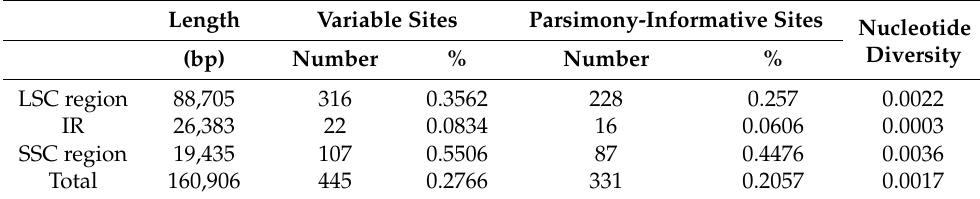
Figure 4. The number of different base substitutions in the plastomes of Crataegus species. Table 4. Analysis of variablesites in the four Crataegus plastomes.